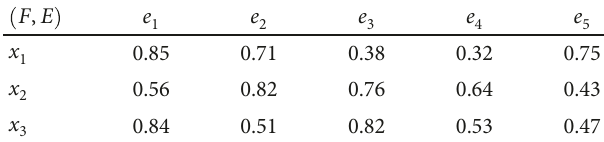
Table 6: Ideal fuzzy soft set F